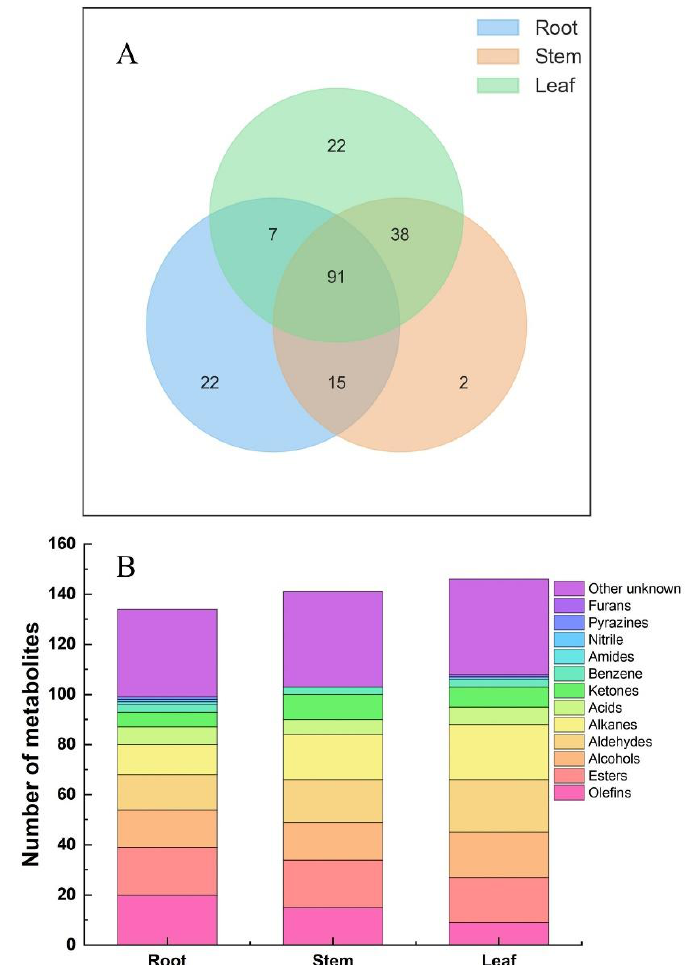
Figure 3. Metabolites of different parts of Houttuynia cordata . ( A ) Wayne diagram of metabolites from Different parts of Houttuynia cordata ; ( B ) Columnar accumulation diagram of different metabolites in Houttuynia cordata .